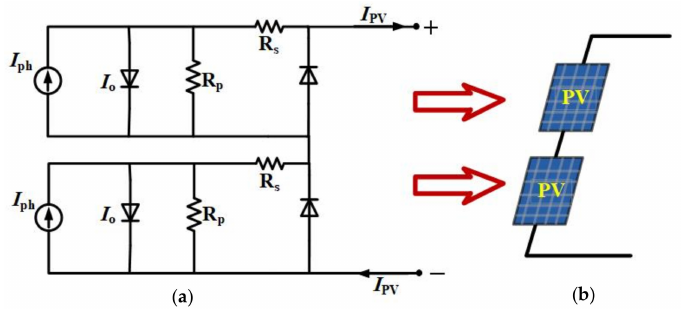
Figure 1. PV array including two series-connected modules ( a ) Circuitry diagram; ( b ) Block diagram. The simulation results of the two series modules of KC200GT type (KYOCERA, Kyoto, Japan) at normal and shading conditions are shown in Figure 2. The PV module parameters at nominal conditions (1000 W/m 2 and 25 ◦ C) are: PV power is 200 W, PV voltage is 26.3 V, and PV current is 7.8 A. Furthermore, module 1 has nominal irradiation (1000 W/m 2 ) while the second module has shading, and its irradiation is 800 W/m 2 . The system has two maxima operating points. Thus, the MPPT algorithm must operate the PV at the global peak. More investigation on different modules and shading conditions will be illustrated in Section 3.